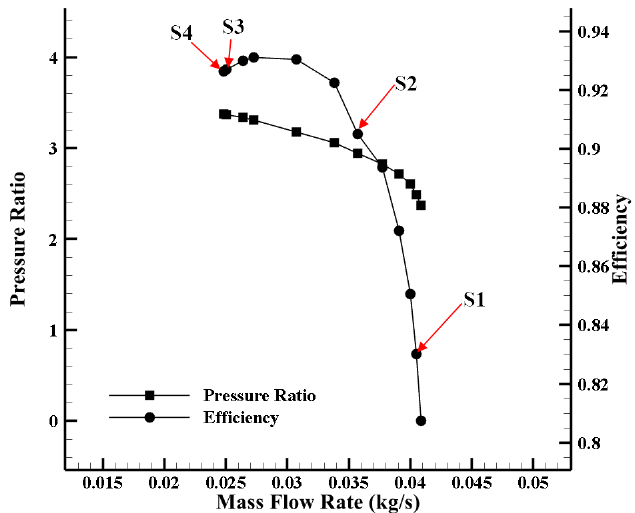
Figure 2. Compressor pressure ratio and efficiency characteristic.